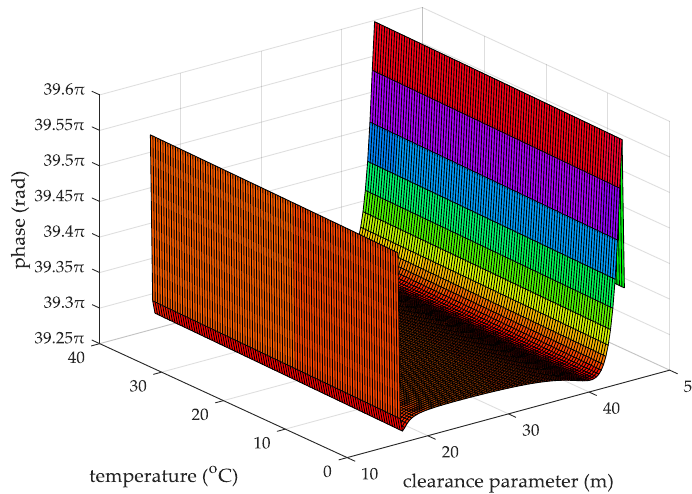
Figure 10. The ASFs of the AIS received signal changing with the seawater temperature and the clearance parameter.